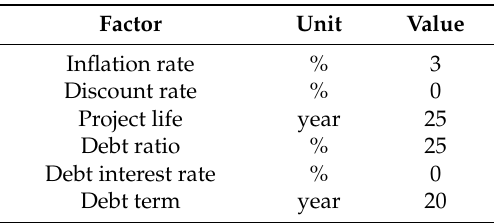
Table 4. Financial Table 4. Financial parameters.